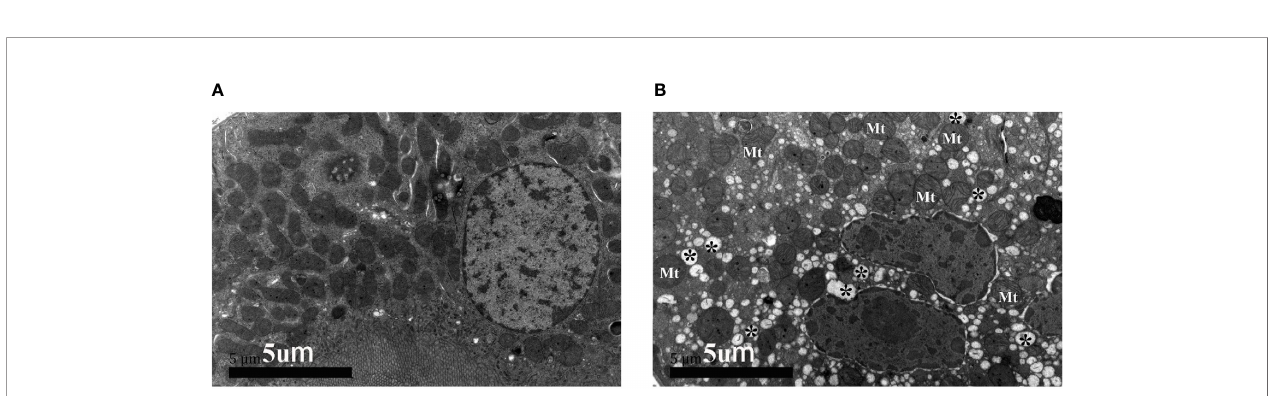
FIGURE 6 | Immunohistochemistry of mouse kidney models. Compared to control (A, B) , the immunohistochemistry of ERS mouse model (C, D) showed that the expression of GRP78 (A, C) and CHOP (B, D) were increased.